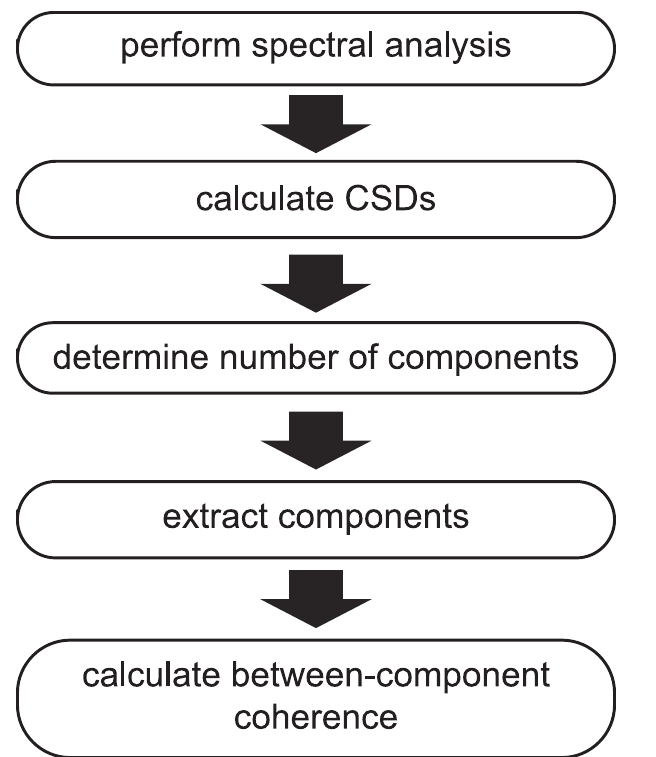
Fig 3. An analysis pipeline for extracting rhythmic components. Extracting components using our method is achieved in several steps, which we present as an analysis pipeline. Electrophysiological recordings are obtained from multiple sensors and multiple trials, and segmented in temporal epochs that reflect trials (or other). A spectral analysis is performed, and subsequently the cross-spectral density matrices (CSDs) are computed, resulting in CSDs per frequency and trial. Once the CSDs are obtained, components can be extracted. The number of components needs to be determined first (e.g. using split-half reliability approach, see Materials and Methods). After extracting the final components, between-component coherence can be estimated. See Results and S1